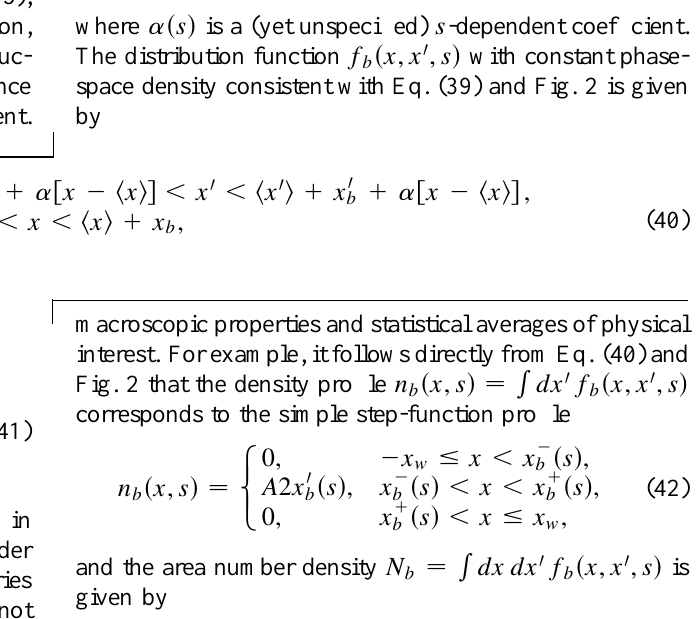
R dx 0 f b (cid:1) x , x 0 , s (cid:2)